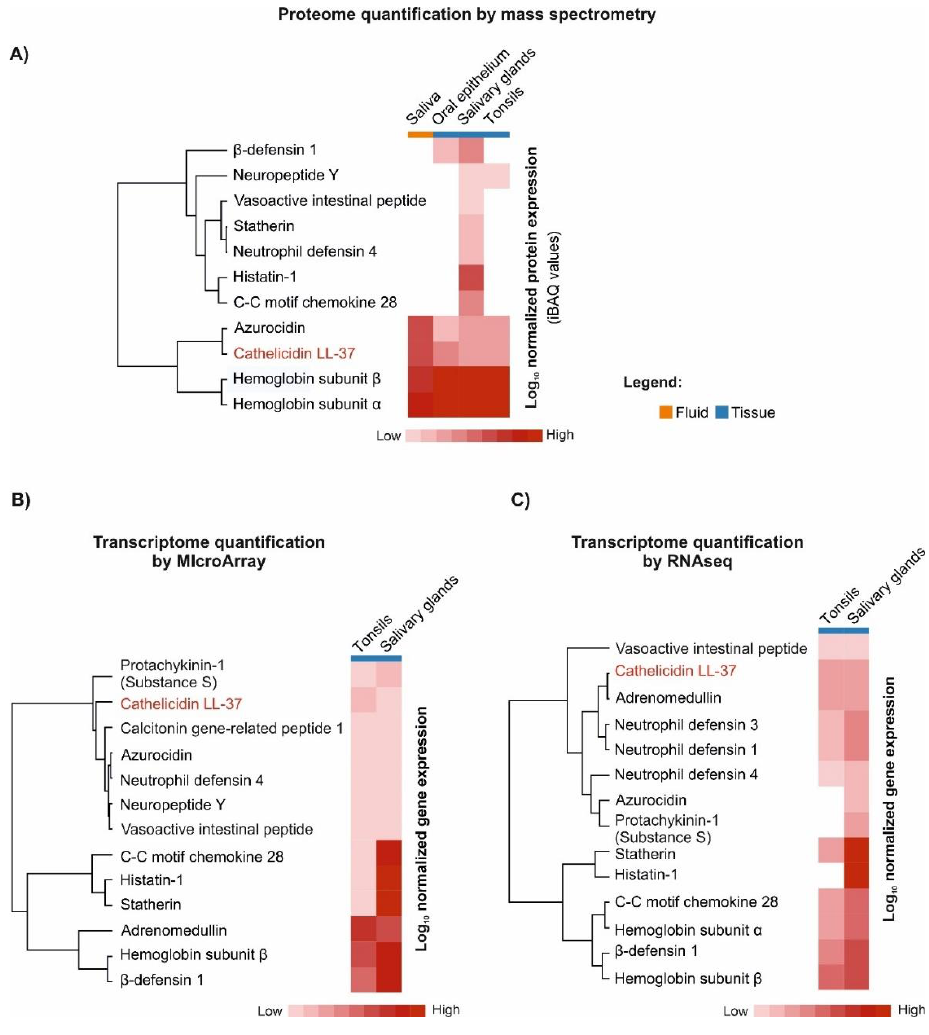
Figure 4. Comparison of CAMPs expression of in saliva, oral epithelium, tonsils and salivary glands. The data were obtained from ProteomicsDB (https://www.proteomicsDB.org) [33] , and represent mass spectrometry (MS1-level) human proteome quantification; the iBAQ (intensity-based absolute quantification) value is a measure of protein abundance, and corresponds to the sum of all the peptides intensities divided by the number of observable peptides of a protein (panel A). Correspondingly, the gene expression results inferred from MicroArray and RNAseq transcriptomic studies are shown in panel B and C, respectively.